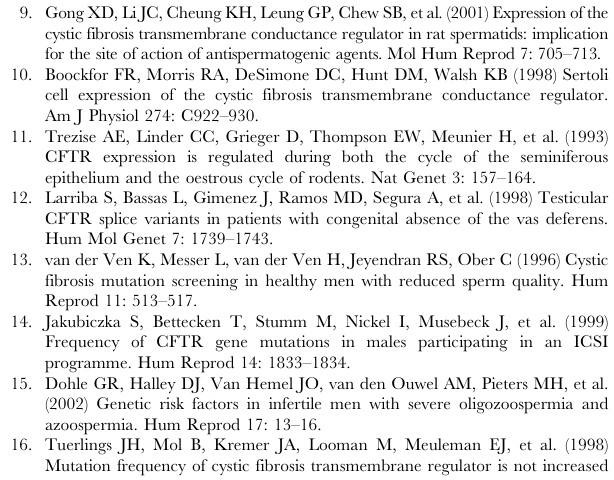
Figure 4 . Reduced CFTR and CREB expression in human azoospermia testes. ( A ) Representative immunoinfluoresence staining of CFTR (red) and Protamine-2 (green) in normal human (n=5) and azoospermia patients (n=6) testes, counterstained with Hoechst (blue). In the normal human testes, Protamine-2 positive signals are localized in the round spermatids (RS, yellow arow) and elongated spermatids (ES, white arrow) (Stages I–II); CFTR positive signals are localized in pachytene spermatocytes (P, blue arrow), RS and Sertoli cells (SC, green arrow) (stages I–VI), especially in RS. In azoospermia testes, no positive signal of Protamine-2 and weak signals of CFTR are detected (Magnification: 400x). Bar =50 m m. ( B ) Statistic analysis of protamine-2 and CFTR positive signal area in normal (n=5) and azoospermia (n=6) human testes samples (***:p , 0.001). ( C ) Immunohistochemistry of CREB in normal human and azoospermia testes. In normal human testes, CREB positive signals are localized in RS (red arrow) and SC (blue arrow). CREB inmmunoreativity in SC is decreased in the testes with spermatogenic arrest obtained from azoospermia patients. Bar =50 m m. ( D ) Statistic analysis of CREB positive Sertoli cell percentage in normal (n=5) and azoospermia (n=6) human testes (***:p , 0.001). Statistic data are shown as mean 6